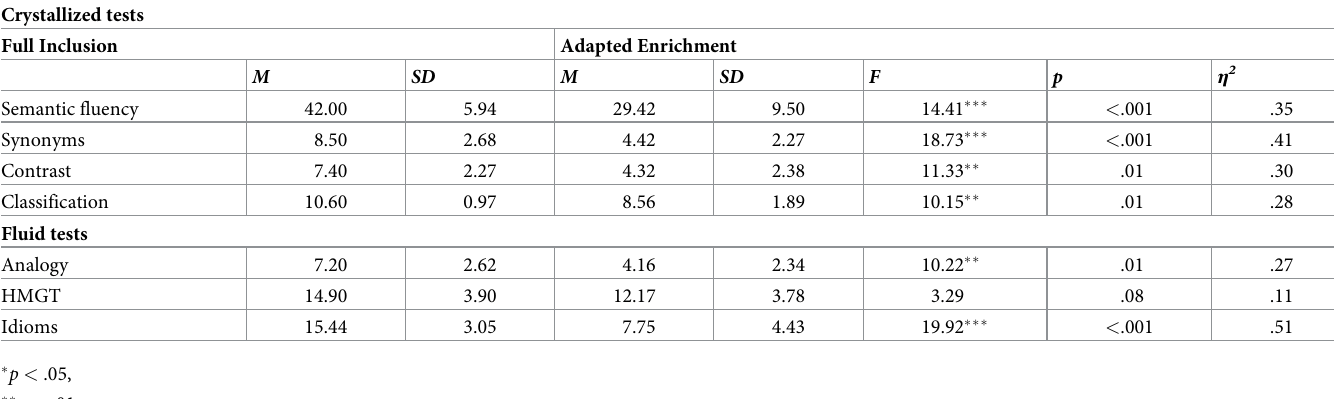
Table 3. Mean, SD, and F values of the crystallized and fluid tests in the full inclusion ( N = 10) and adapted enrichment ( N = 21) groups. Crystallized tests